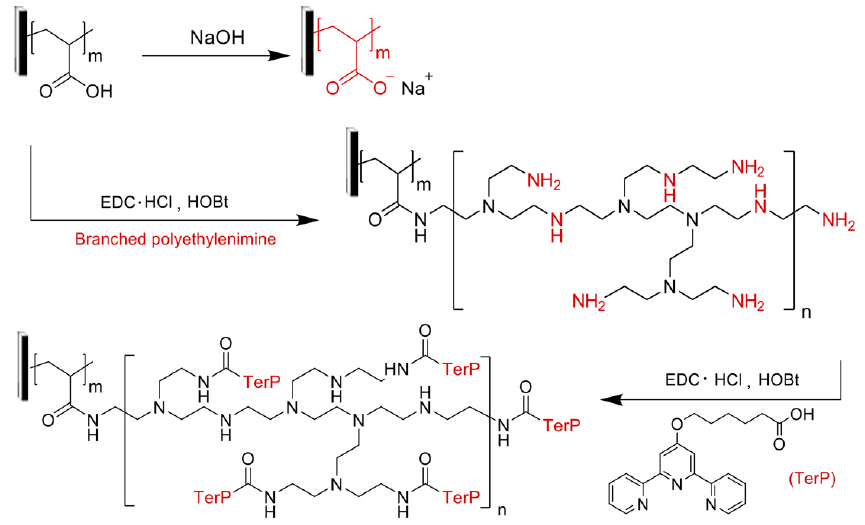
Figure 16. The coupling reaction schemes utilized to convert the pore wall chemistry from a parent PAA-lined pore to a terpyridine-lined pore through an intermediate polyethylenimine-lined (PEI- lined) pore. Reproduced from [168], used under CC-BY 4.0.